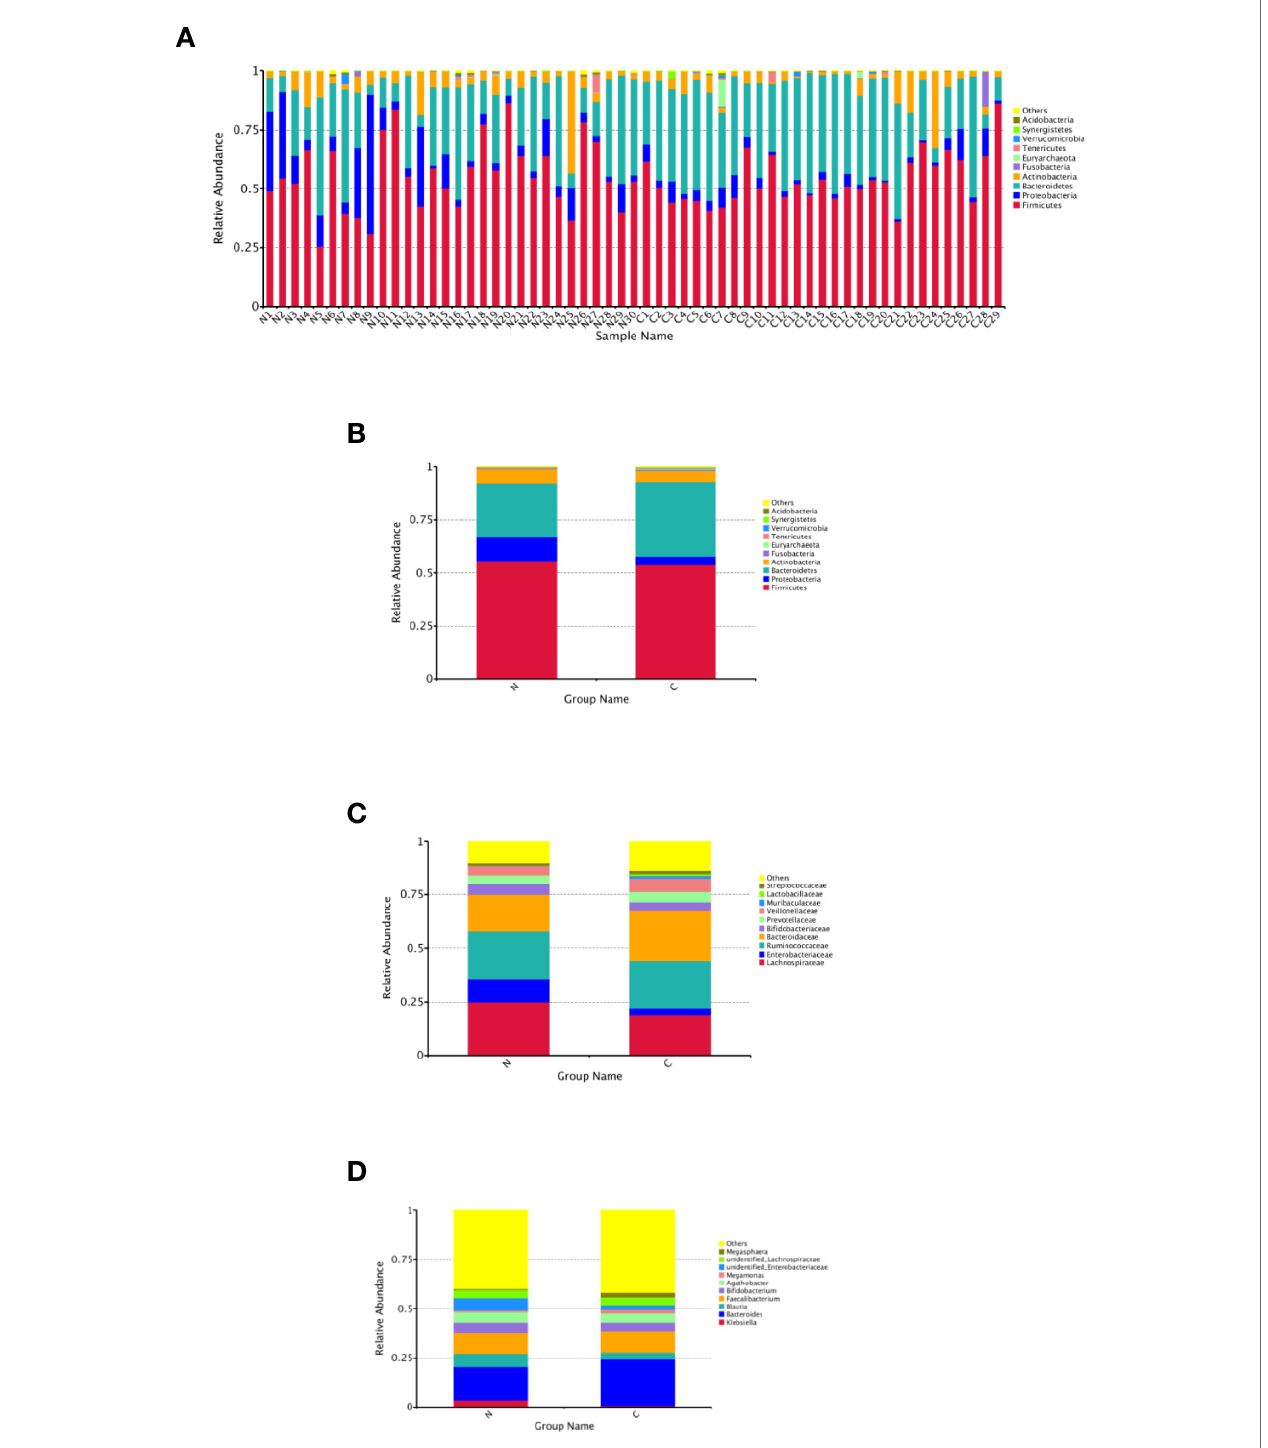
FIGURE 2 | Relative abundance distribution at different levels of the gut microbiome in two groups. Here we analyze mainly at the level of Phylum, Family, Genus. (A) The relative abundance histogram of phyla in each sample. (B) The predominant phyla in the two groups. (C) The predominant family in the two groups. (D) The predominant genera in the two